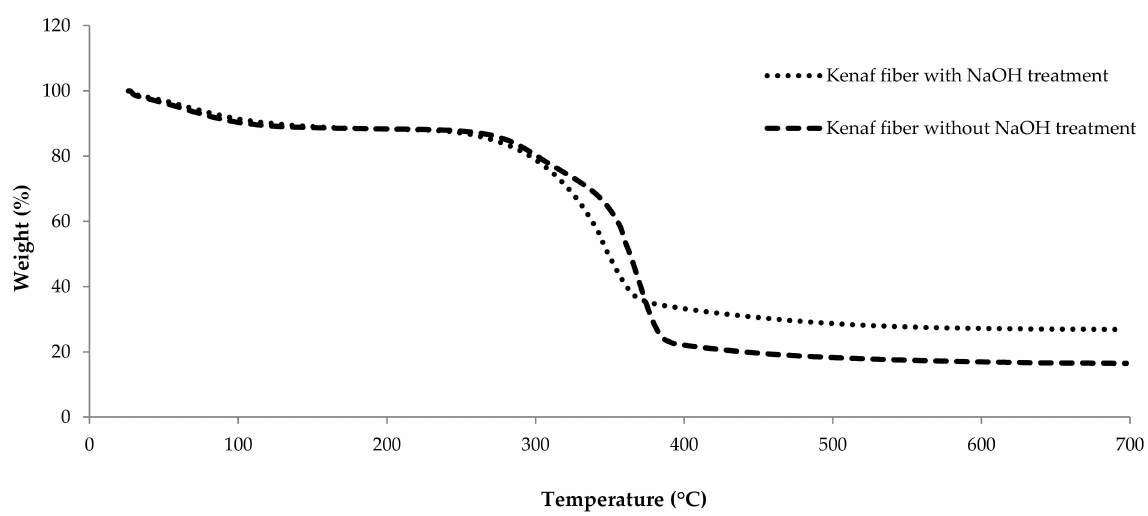
Figure 4. Thermogravimetric analysis (TGA) curves for kenaf fiber with NaOH treatment and without NaOH